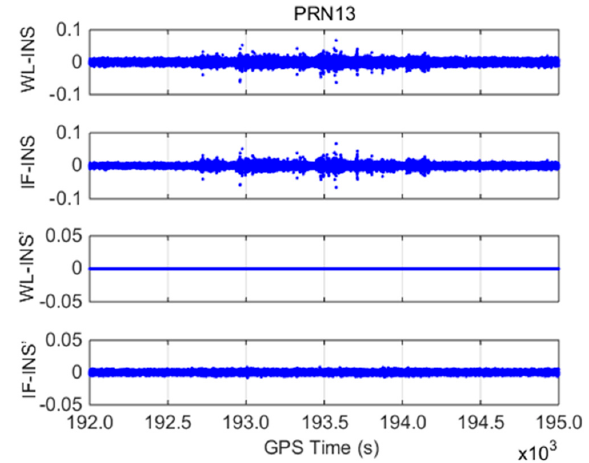
Figure 4. Cycle slip (CS) detection models for PRN13 (unit: meter).